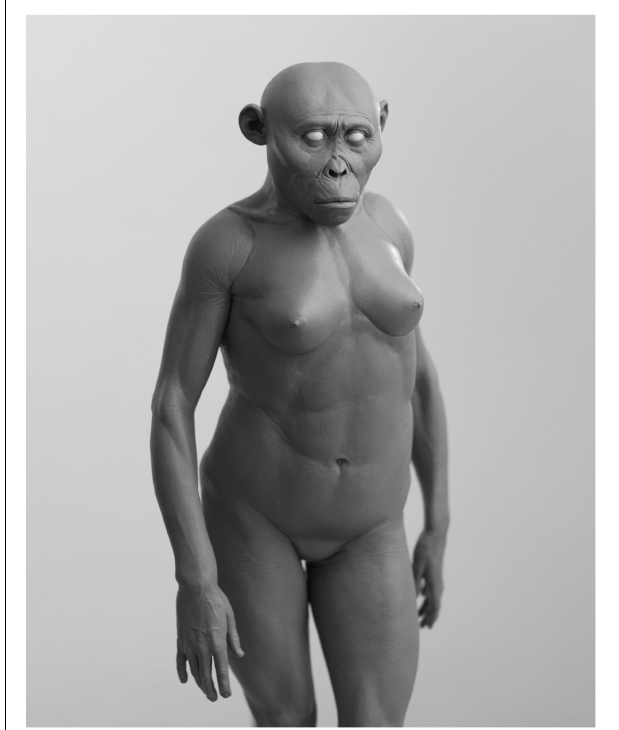
FIGURE 2 | An intuitive reconstruction of Lucy’s soft tissues (without hair and pigment) produced in 2018 and reconstructed over the digitally reconstructed A.L. 288-1 skeleton published in Brassey et al.